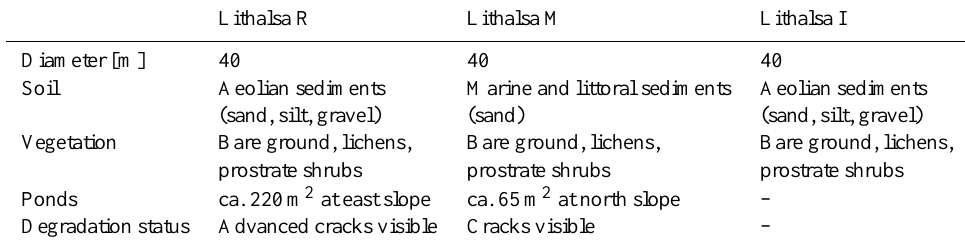
Table 2. Characteristics of the three